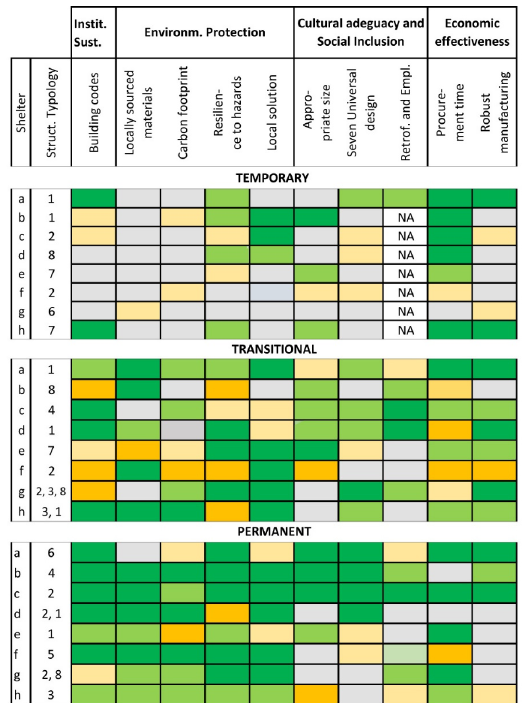
Figure 9. Highlights from the Kesselring matrix used within the categorization process. Letters refer to the case studies in Figures 7–9 and numbers refer to the structural typology, which reads (1) steel, (2) timber, (3) masonry, (4) bamboo, (5) adobe, (6) container, (7) tent, and (8) others. Darker green colour shades indicate compliance with the indicator’s criteria, and darker orange colours indicate non ‐ compliance. Gray indicates an area with insufficient information.